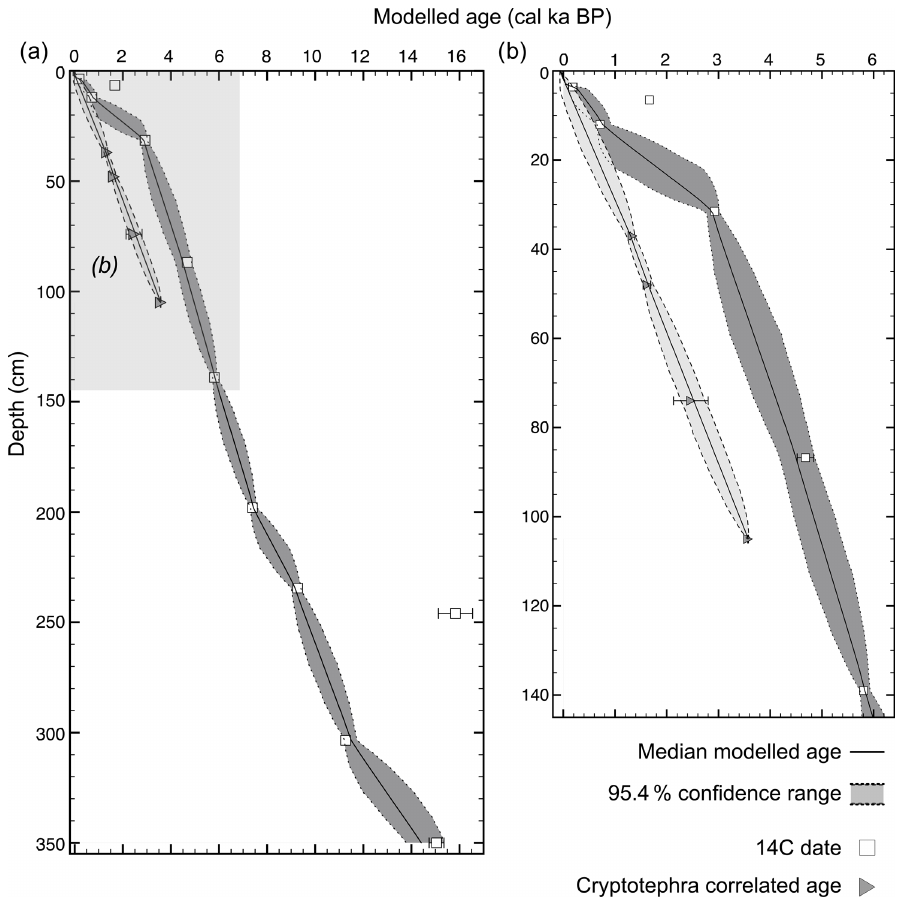
Figure 5. Cascade Lake core CASC-4A/2D multi-method chronometer comparison of downcore age models based on radiocarbon ages (dark grey shading) and correlated tephra ages (data are reported in Table S6). Two sigma uncertainties are plotted for all samples; where bars are not visible, the uncertainty is smaller than the symbol. (a) All 14 C dates produced by Steen (2016) from CASC-4A/2D; (b) the focused upper section with new cryptotephra analyses from this